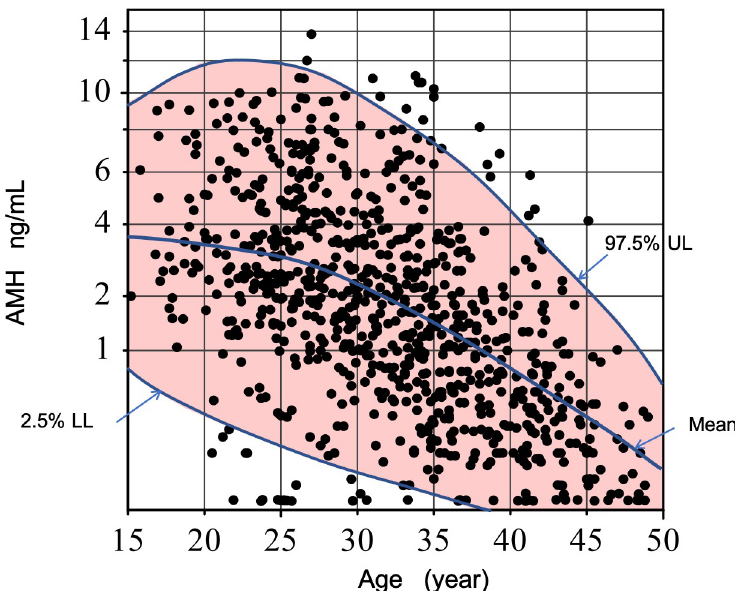
Fig 5. Nomogram of age-related profile of Antimullerian hormone (AMH). The scale is adjusted to fit the AMH power transformation. The central lines and the outer margins of the colour shades represent the median and the fifth and 95th centiles for the year-by-year moving vertical 10-year segment.